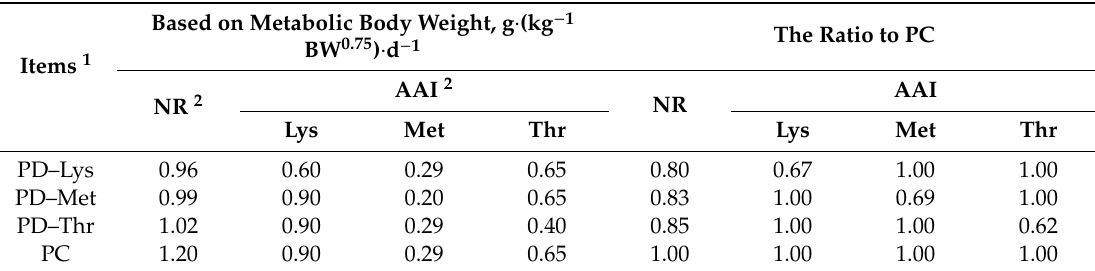
Table 5. The proportions of amino acid intake and nitrogen retention in PD–Lys, PD–Met, and PD–Thr to those in the PC